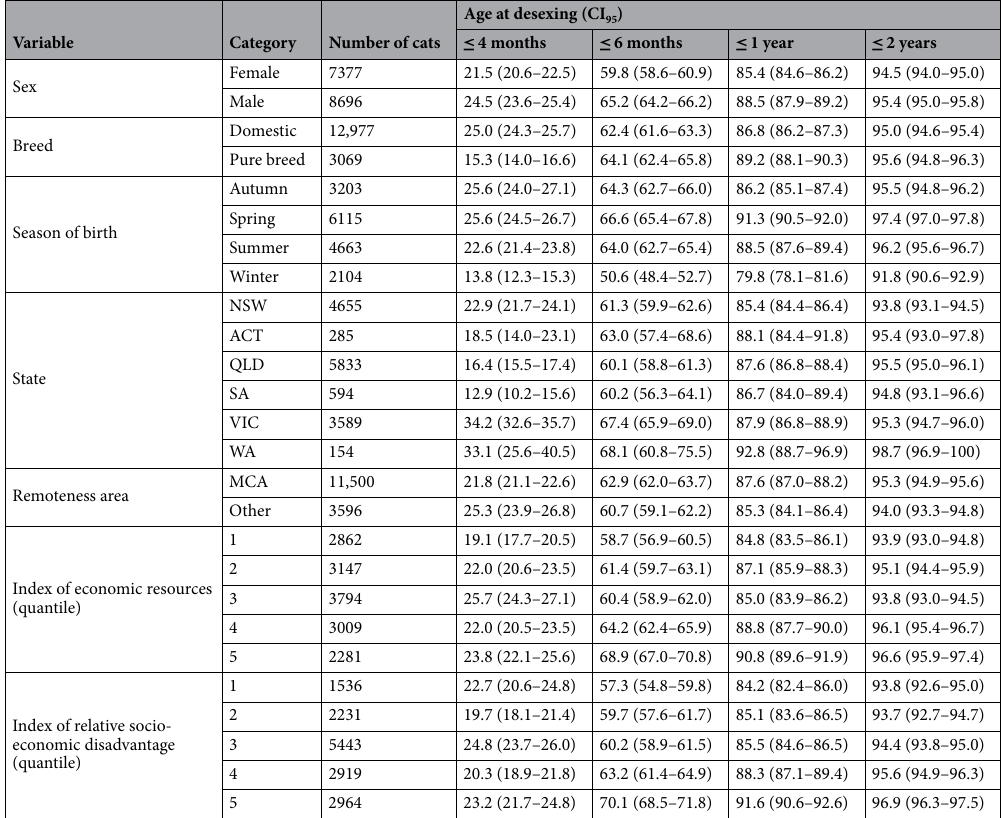
Table 2. Prevalence (%) of cats desexed before each age cut-off in an Australian cohort of desexed cats born between 2010 and 2017 inclusive. CI confidence interval, MCA major cities of